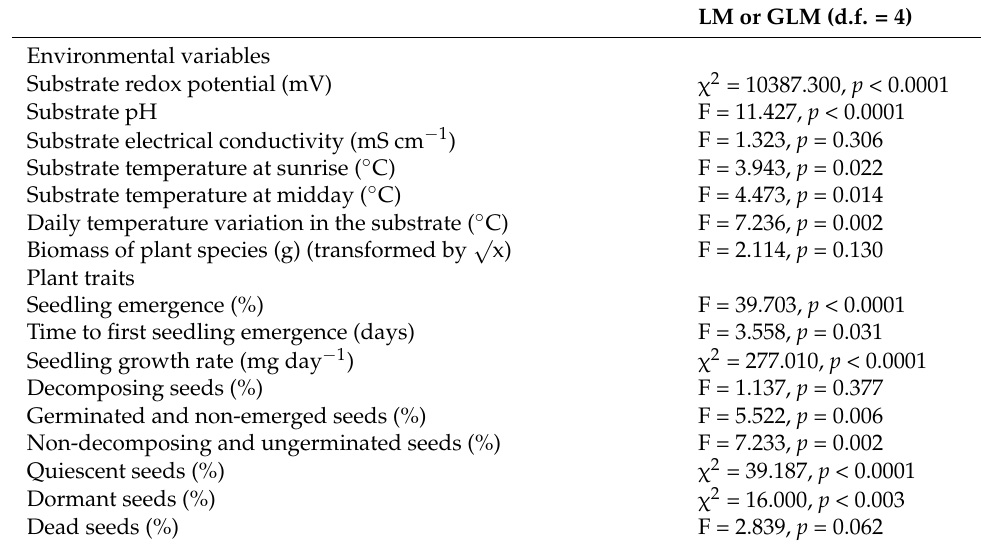
Table 1. Results of linear model (LM) and generalized linear model (GLM) for environmental variables and plant traits of Iris pseudacorus with wrack burial depth as fixed factor. d.f., degree of